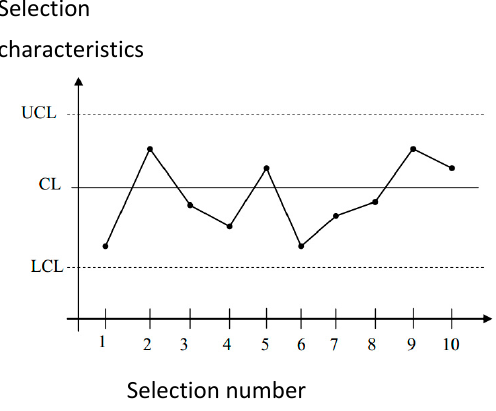
Figure 3. Shewhart control chart. 3.3. Control Diagram for the Range of Variation and Control Diagram for the Arithmetic Control diagram for the selection range of variation [24,25]